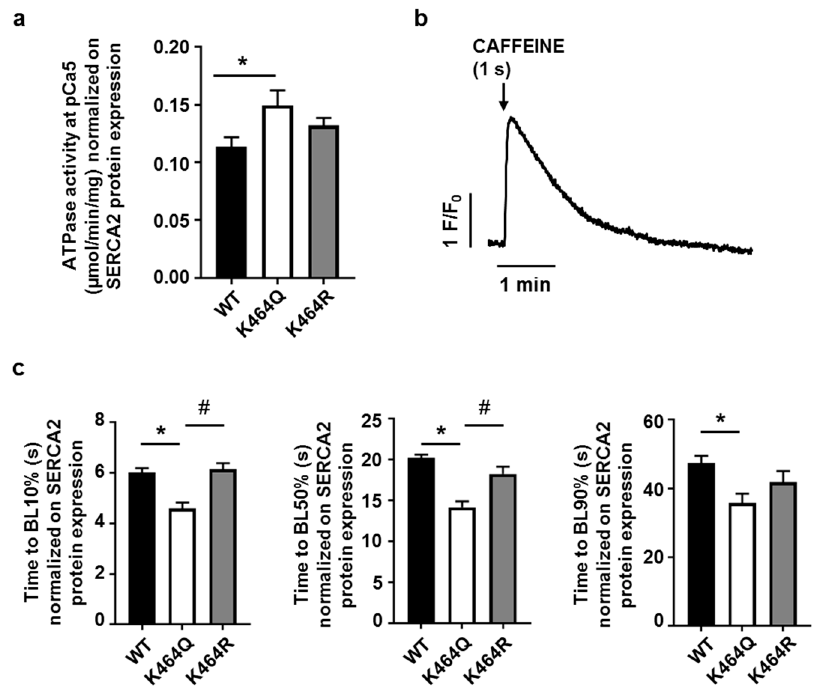
Figure 5. ATPase activity on microsomes and calcium transients evaluated in HEK cells transfected with human SERCA2a mutants. ( a ) ATPase activity assay performed on microsomes isolated from stable transfected HEK cells at pCa5 normalized on SERCA2 protein expression. Experiments were performed on 4 independent HEK sets per group and repeated twice. Ordinary one-way ANOVA followed by Bonferroni’s multiple comparison: p < 0.005 WT vs. K464Q. All data are presented as mean ± SEM; ( b ) Representative trace of the rise in intracellular calcium concentration evoked by a caffeine pulse in untransfected HEK cells; ( c ) Calcium transients in SERCA2a K464 mutants normalized on SERCA2 protein expression. K464 is mutated either into Q or R, mimicking constitutive acetylation and deacetylation, respectively ( n = 99 WT, n = 69 K464Q and n = 36 K464R). Time to 10% (BL10) and time to 90% (BL90) were analysed by Kruskal-Wallis followed by Dunn’s multiple comparisons test: * p < 0.005 WT vs. K464Q, # p < 0.005 K464Q vs. K464R. Time to 50% (BL50) was analysed by ordinary one-way ANOVA followed by Bonferroni’s multiple comparisons test: * p < 0.005 WT vs. K464Q, # p < 0.005 K464Q vs. K464R. All data are presented as mean ± SEM.